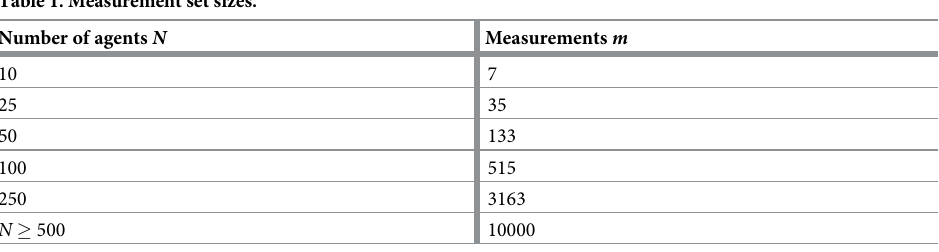
Table 1. Measurement set sizes.